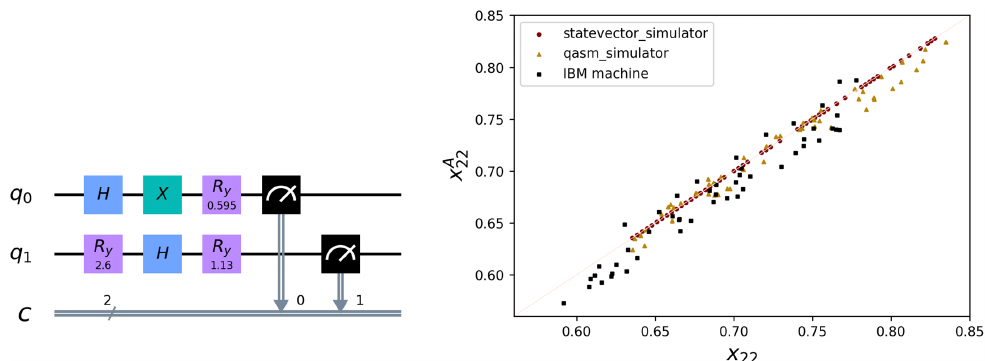
FIG. 7. Plots of the true ( x 22 ) versus the predicted ( x A ) mean measurement values for the 2-qubit SU ( 4 ) case for the shown gate 22 model using the three backends statevector_simulator , qasm_simulator , and ibmqx2 . The reconstructed density matrix accurately predicts x 22 in the case of the statevector_simulator method, whereas slight deviations are observed in the cases of the qasm_simulator method and the IBM machine